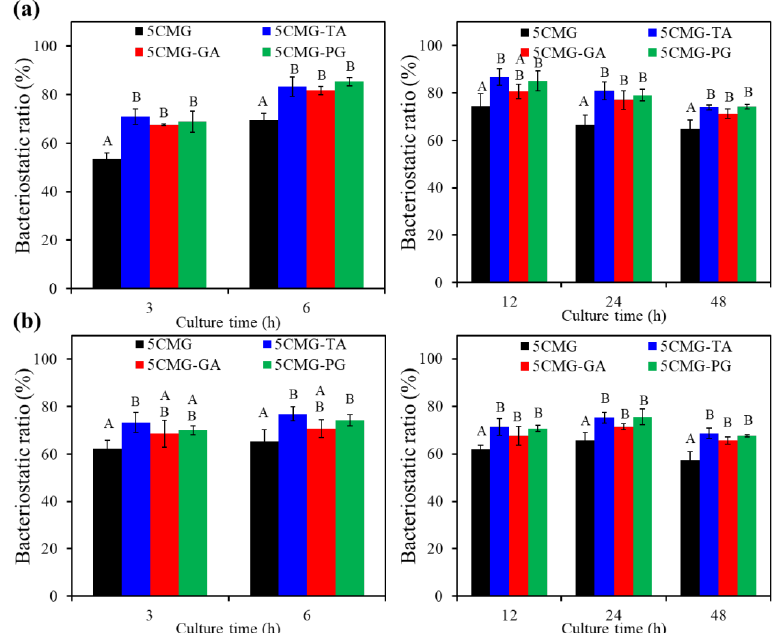
Figure 10. Bacteriostatic ratio of the various samples with and without polyphenols (TA, GA, and PG) against ( a ) P. gingivalis and ( b ) S. mutans bacterial species after culture for short - term and long - term time points. Statistical comparisons were made between samples incubated at the same time point. Different capital letters indicated significant differences at p < 0.05.